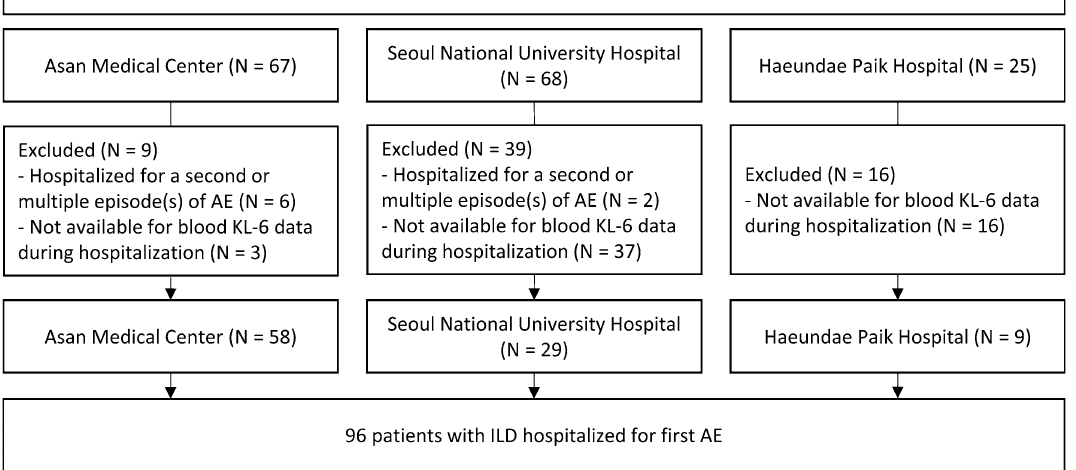
Figure 1. Flowchart of patient selection. ILD interstitial lung disease, AE acute exacerbation, KL-6 Krebs von den